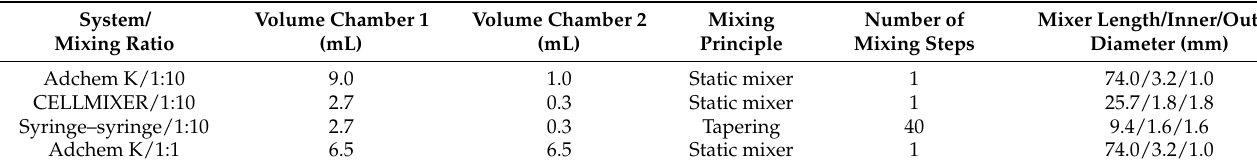
Table 1. Major characteristics of the mixing devices used in this study.